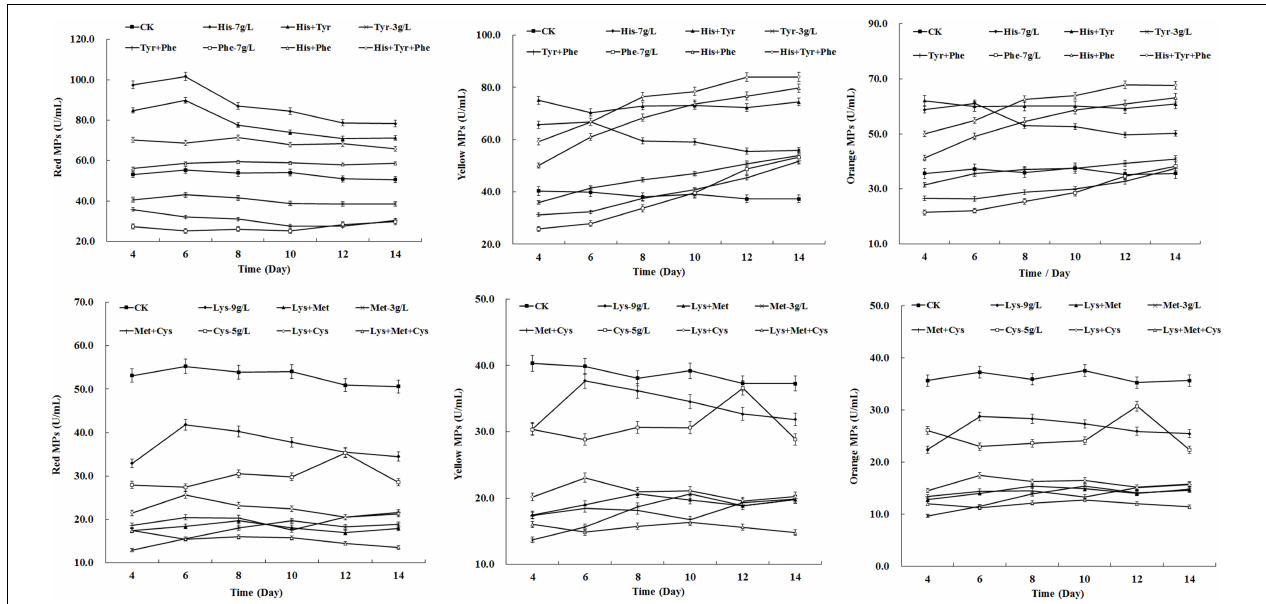
FIGURE 3 | Effects of combination of amino acids on Monascus pigments (MPs) production in Monascus purpureus RP2 fermentation. CK, M. purpureus RP2 fermentation without the addition of amino acid; His, M. purpureus RP2 fermentation with the addition of HIS; Tyr, M. purpureus RP2 fermentation with the addition of TYR; Phe, M. purpureus RP2 fermentation with the addition of PHE; Met, M. purpureus RP2 fermentation with the addition of MET; Lys, M. purpureus RP2 fermentation with the addition of LYS; Cys, M. purpureus RP2 fermentation with the addition of